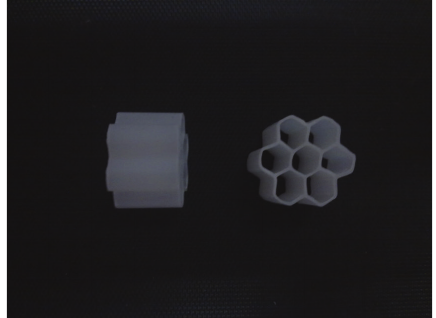
Figure 2: Growth media used in this study, model: BC-800.